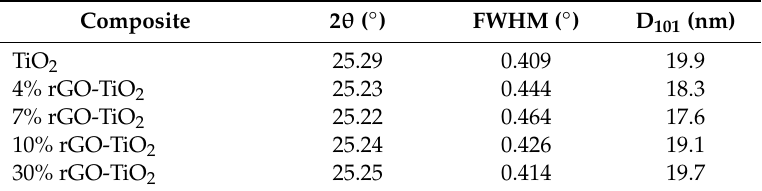
Figure 3. XRD patterns for rGO-TiO 2 composites. Table 3. Parameters obtained from XR di ff ractograms: di ff raction peak position (2 θ ), full-width at half maximum (FWHM), and crystal size (D 101 ).